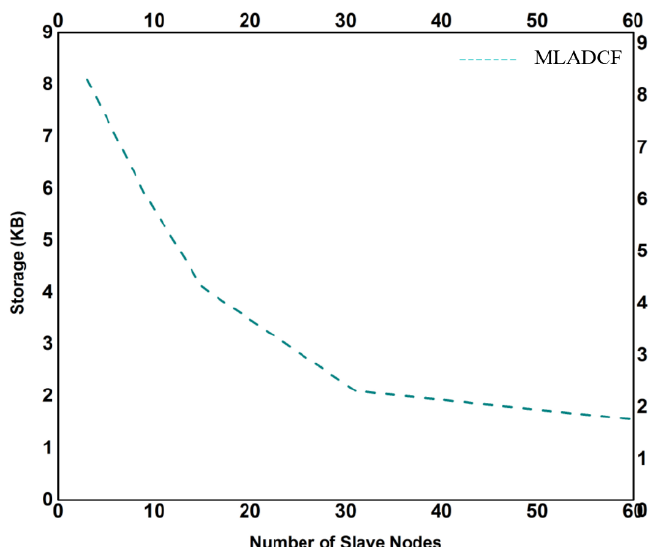
Figure 11. No. of Slave Nodes Vs. Storage.